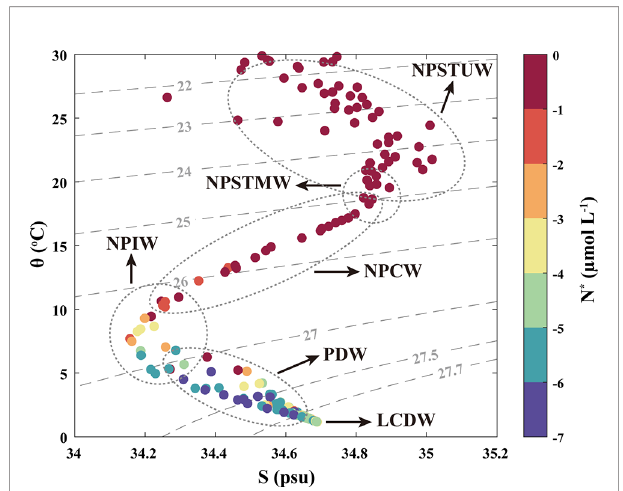
FIGURE 2 | The potential temperature ( q ) and salinity (S) distributions are labeled with N*. The dotted grey lines represent the extent of water masses, and the dashed lines represent the potential density anomaly ( s q – 1000 kg m − 3 ) of the STWNPO. Acronyms: North Paci fi c subtropical underwater (NPSTUW), North Paci fi c subtropical mode water (NPSTMW), North Paci fi c central water (NPCW), North Paci fi c intermediate water (NPIW), Paci fi c deep water (PDW), and lower circumpolar deep water (LCDW). This fi gure is also available with a gray color version in Supplementary Materials